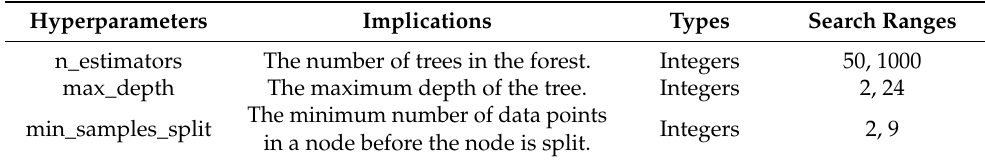
Table 5. Hyperparameters of the random forest model tuned in this study [37–39,42]. Hyperparameters